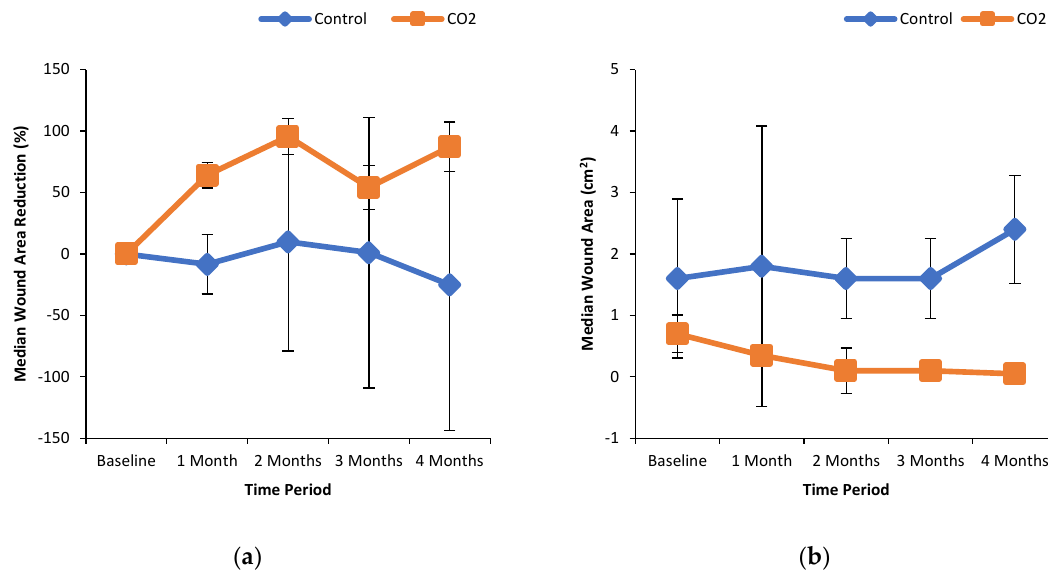
Figure 1. Effect of CO 2 -water bathing on the dimensions of foot ulcers. Panel ( a ) percent wound area reduction of foot ulcers and panel ( b ) wound area in patients treated without and with CO 2 -enriched water. Study participants were randomized to undergo foot bathing either with CO 2 -enriched tap water (37 ± 0.5 °C; CO 2 concentration of 1000 – 1200 ppm) or with regular tap water (37 ± 0.5 °C) with an immersion time of 15 min for 3 times/week for up to 16 weeks for a total of 48 treatments. The Silhouette Mobile camera (ARANZ Medical, Christchurch, New Zealand) was used to measure the dimensions of the ulcer.